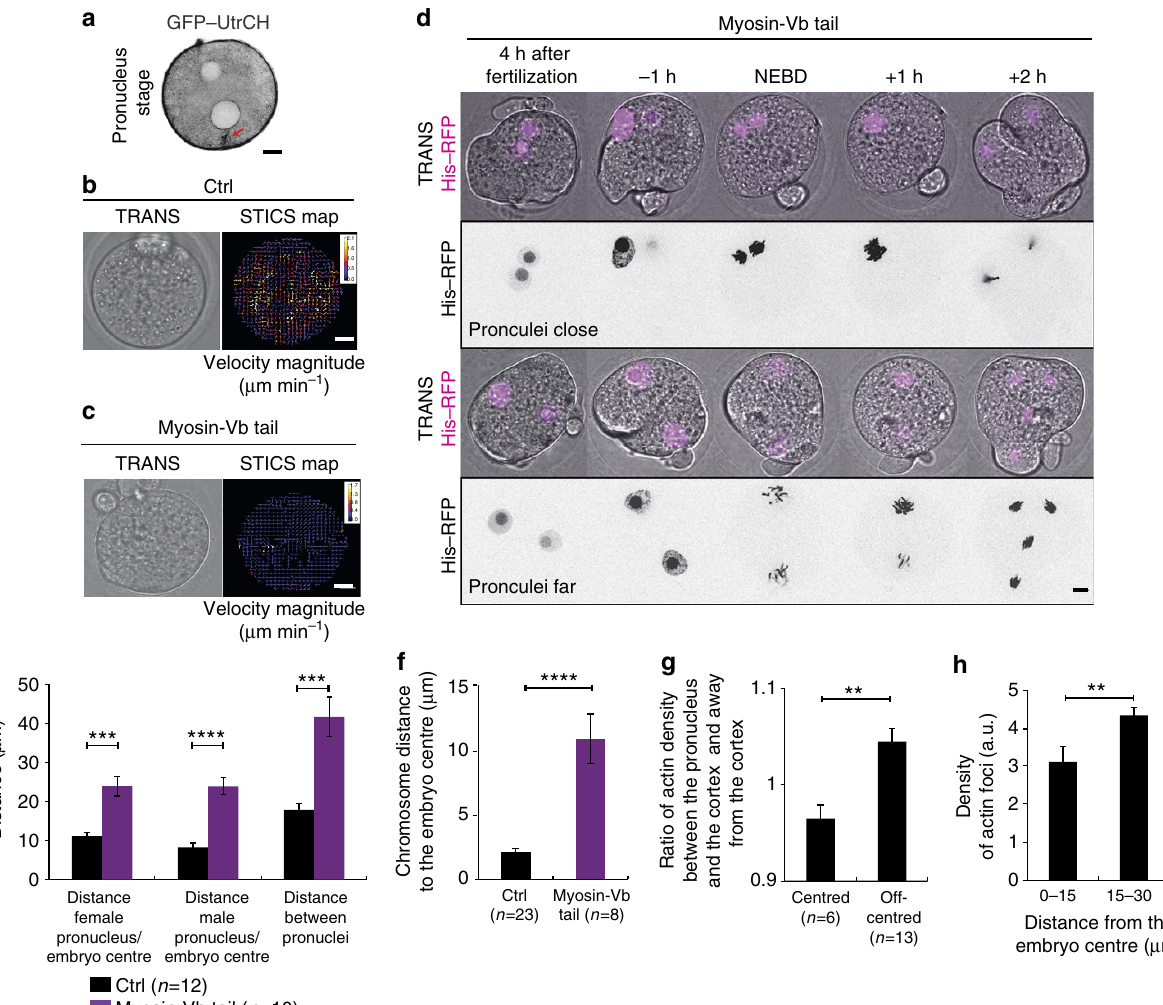
Figure 2 | F-actin and Myosin-Vb-driven cytoplasmic flows position the pronuclei in the central region of the embryo. ( a ) Control embryo expressing GFP–UtrCH (black, one Z-plane is shown). The red arrow points at actin enrichment. Scale bar, 10 m m. ( b , c ) Left panels: embryos expressing ( c ) or not ( b ) Myosin-Vb tail. Right panels: associated vector maps of cytoplasmic flows obtained using STICS analysis. Heat bar unit in micrometres per minute. Scale bars, 10 m m. One example is shown out of 11 controls and 13 Myosin-Vb tail embryos. ( d ) Embryos expressing His–RFP (purple or black, Z-projection over 20 m m). Upper panels: pronuclei close; lower panels: pronuclei far. Scale bar, 10 m m. ( e ) Bar graph showing the pronuclei distance to the embryo centre and to each other 1h before NEBD for controls (black bars) or Myosin-Vb tail-expressing embryos (purple bars). Mean is shown of 12 controls and 10 Myosin-Vb tail embryos. s.e.m. is plotted on each bar. Statistical significance of differences is assessed with a t -test or a t -test with Welch correction ( P values: female pronuclei/embryo centre: 0.0005; male pronuclei/embryo centre o 0.0001; between pronuclei: 0.0009). ( f ) Bar graph showing the chromosome mass distance to the embryo centre in metaphase for controls (black bar) and Myosin-Vb tail-expressing embryos (purple bar). Mean is shown for 23 controls and 8 Myosin-Vb tail embryos. s.e.m. is plotted on each bar. Statistical significance of differences is assessed with a Mann–Whitney test ( P value o 0.0001). ( g ) Graph bar showing the ratio of GFP–UtrCH fluorescent intensity between the pronucleus and the cortex and on the other side of the pronucleus. Mean is shown for 6 centred and 13 off-centred pronuclei embryos. s.e.m. is plotted on each bar. Statistical significance of the difference is calculated with a Mann–Whitney test ( P value 0.0014). ( h ) Graph bar showing the mean percentage of actin-positive foci in each region of the embryo normalized by the effective surface of the region. Mean is shown from 9 embryos out of 2 independent experiments. s.e.m. is plotted on each bar. Statistical significance of the difference is calculated with a Mann–Whitney test ( P values